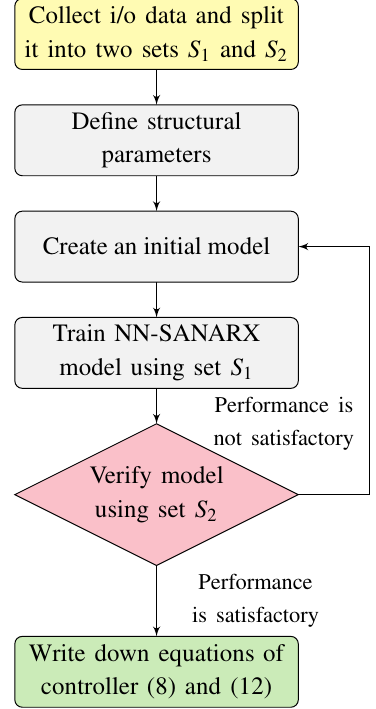
Fig. 3. Schematic diagram of the